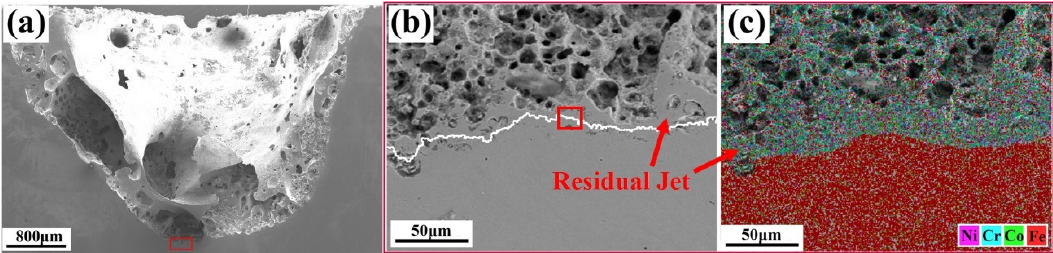
Figure 3. SEM image of the CoCrNi residual jet after penetration observed along the penetration direction at the bottom of the jet crater. The residual jet region is marked by the red arrow in ( b ) and ( c ). ( a ) SEM image of the bottom of the jet crater. ( b ) Magnified view of the region marked with a red rectangle in ( a ). ( c ) SEM-EDS mapping of ( b ).